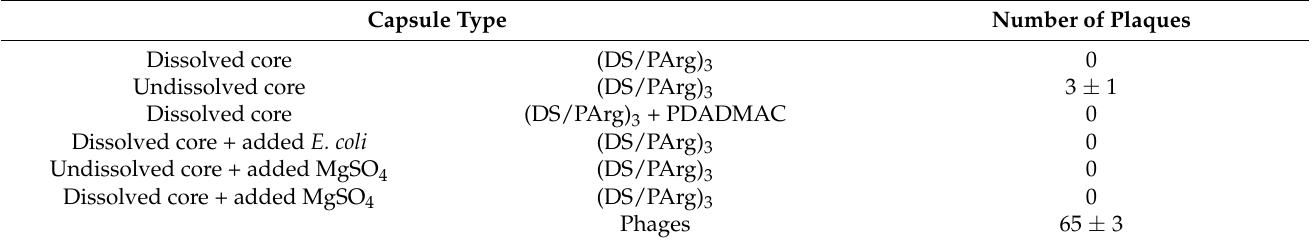
Table 1. Activity of encapsulated bacteriophages in biodegradable polyelectrolyte